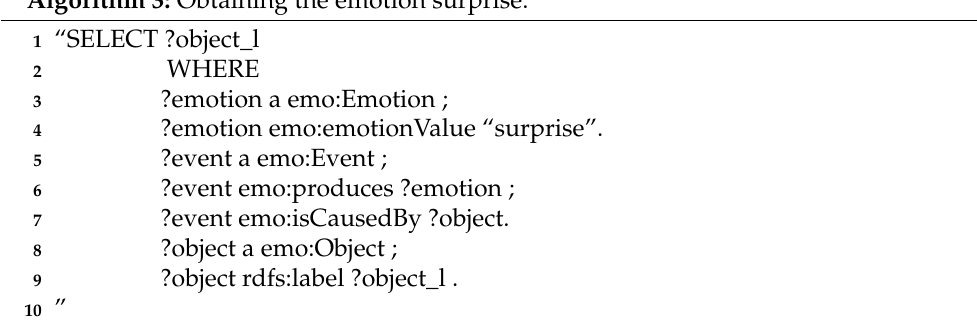
Algorithm 3: Obtaining the emotion